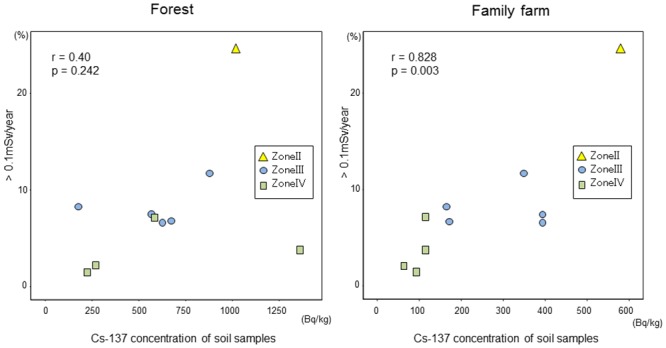
Correlation between mean 137Cs concentration of soil samples and rate of population with dose of >0.1mSv/year of each city.